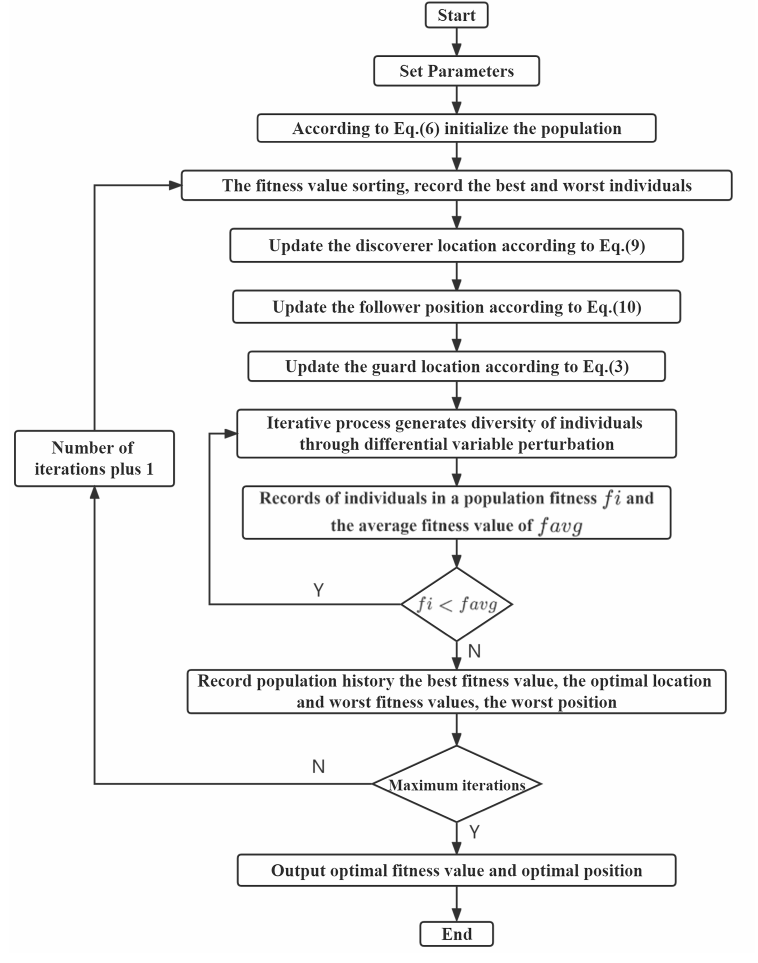
Figure 3. Flow chart of